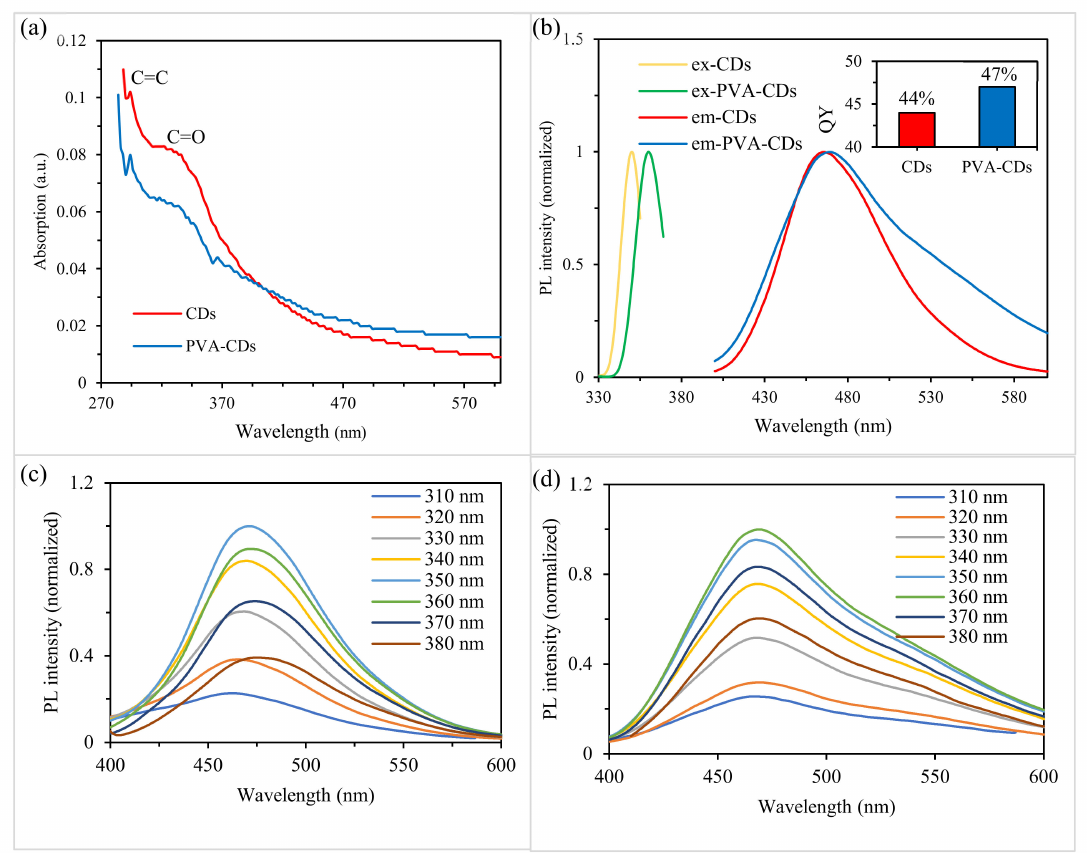
Figure 4. ( a ) UV-Vis absorption spectra of bare CDs and PVA-CDs film with inset photographs under daylight (left) and UV-light (right), ( b ) PL emission with inset showing QY, ( c ) excitation-dependent emission spectra of pared CDs and ( d ) excitation-dependent emission spectra of PVA-CDs